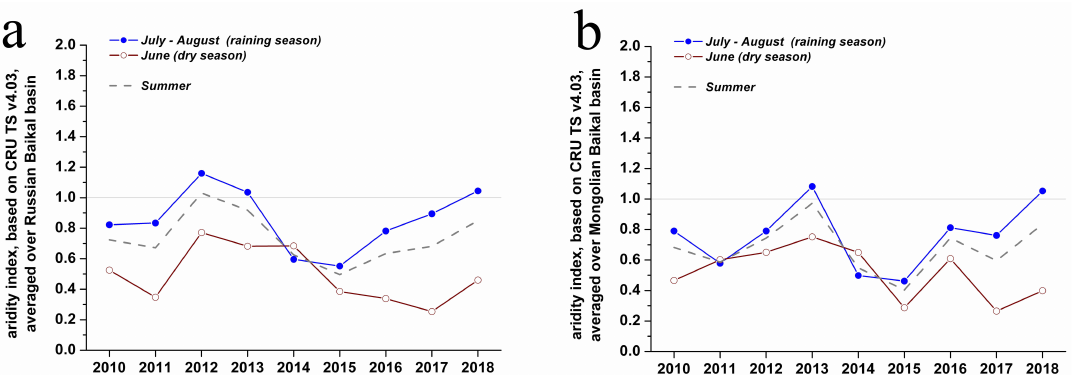
Figure 11. The aridity indexes, spatial averaged over the territory of the Russian ( a ) and the Mongolian parts ( b ) of the Baikal basin, for the wet period (July–August, blue lines), dry period (June, brown lines), and the whole summer (June–August, gray dashed lines). The aridity index was calculated using the CRU TS climatic dataset.